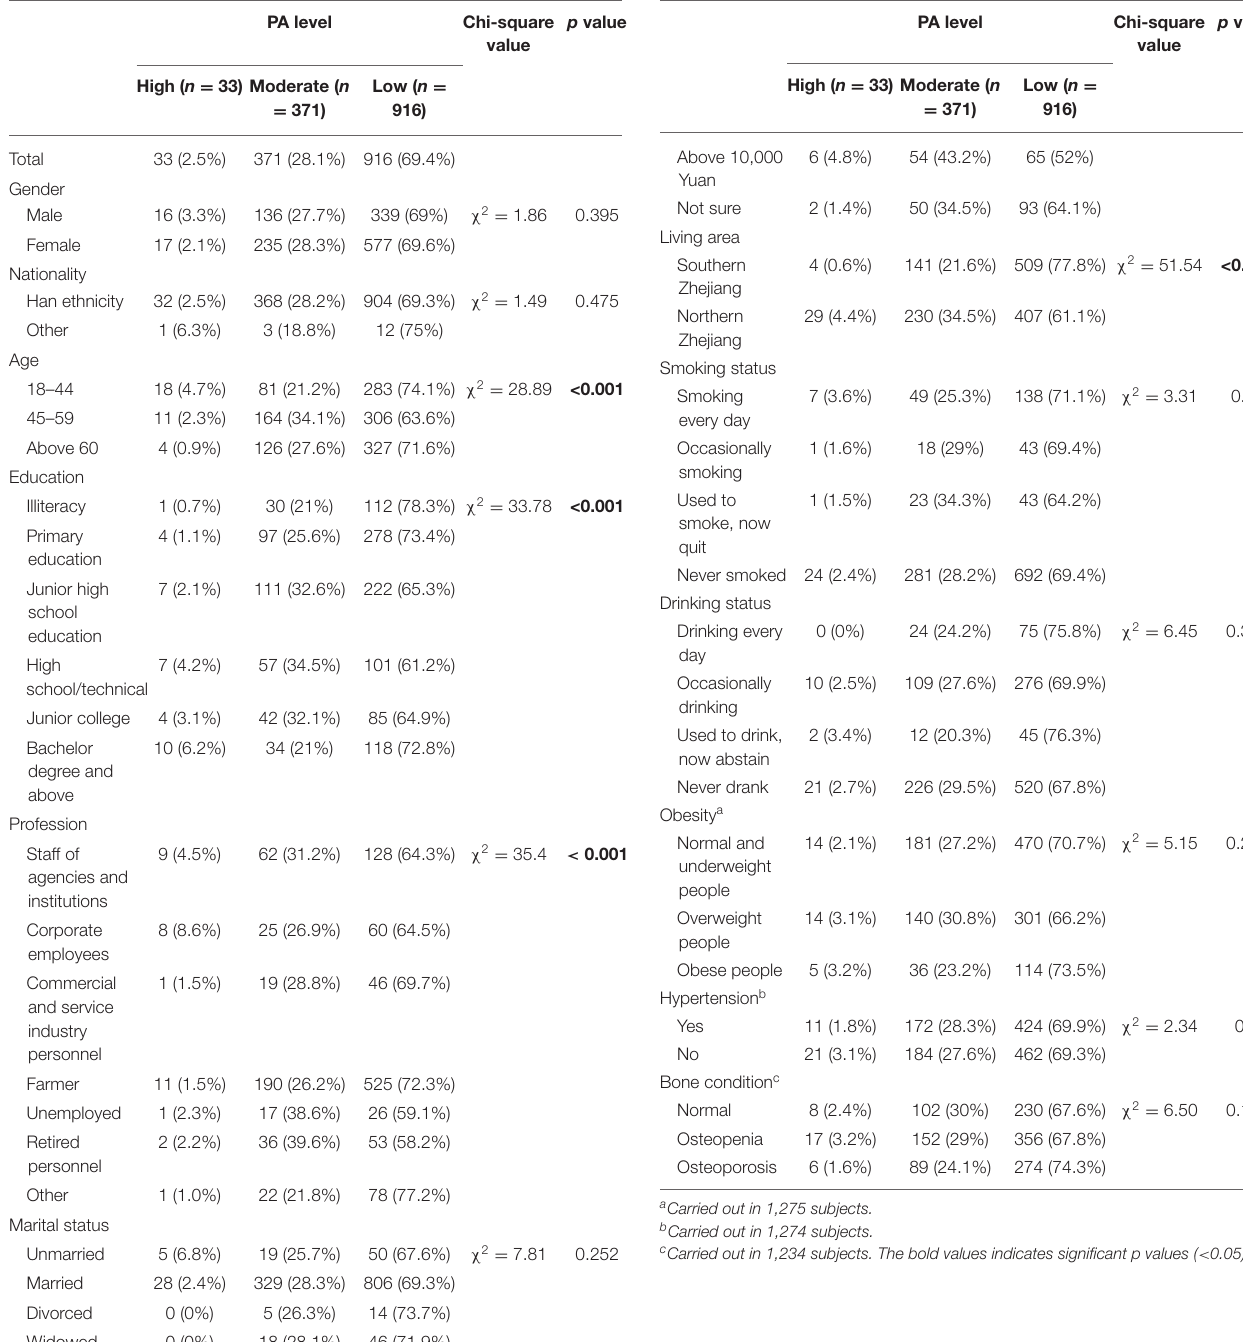
TABLE 3 | Analysis of the PA level of residents in rural areas of Zhejiang